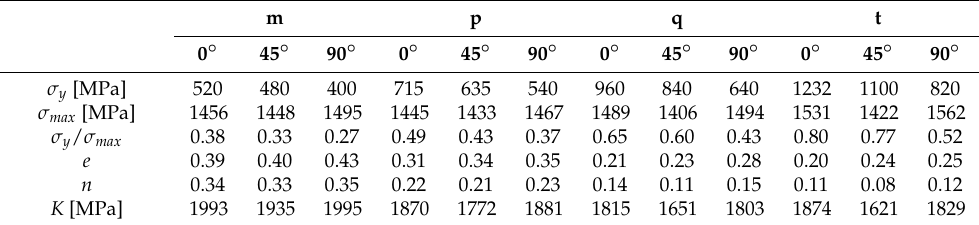
Table 1. Mechanical properties obtained in each test